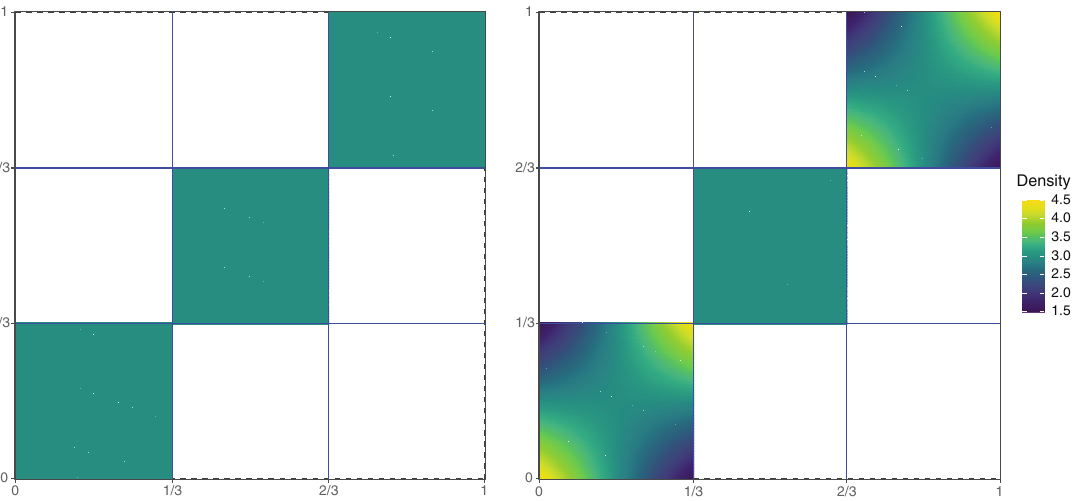
Figure 2: Density of the SI copulas C Π ( left panel ) and A ( right panel ) considered in Example 3.6. Although A x y C x y , , Π ( ) ( ) ≥ holds for every x y